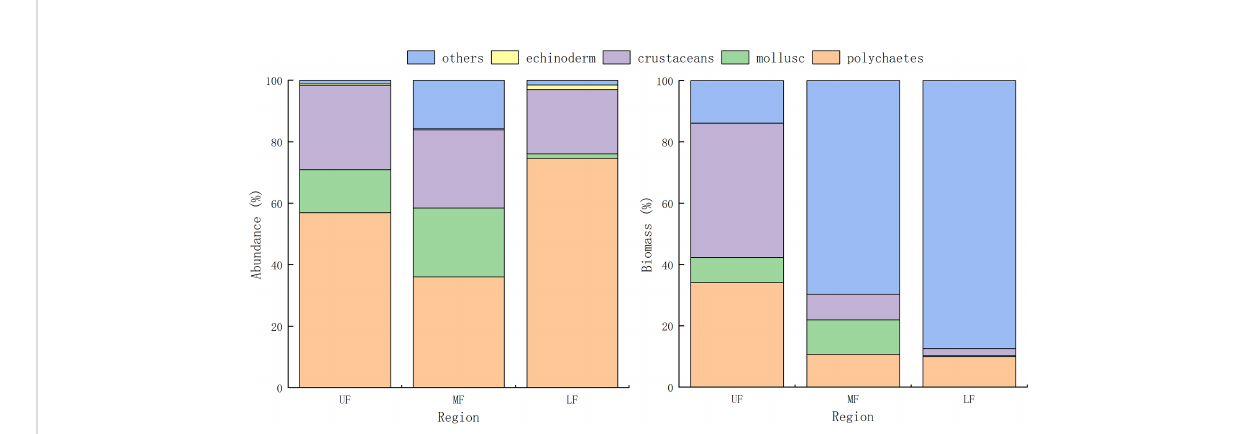
FIGURE 9 Abundance and biomass precent of macrobenthos in and adjacent to the secondary front, Hangzhou